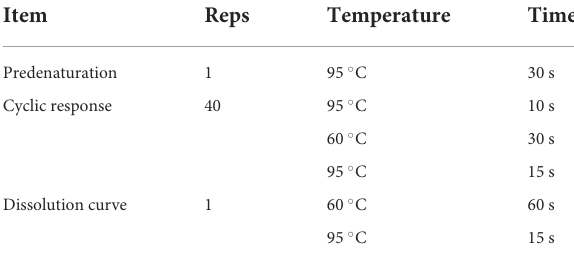
TABLE 4 RT-qPCR reaction